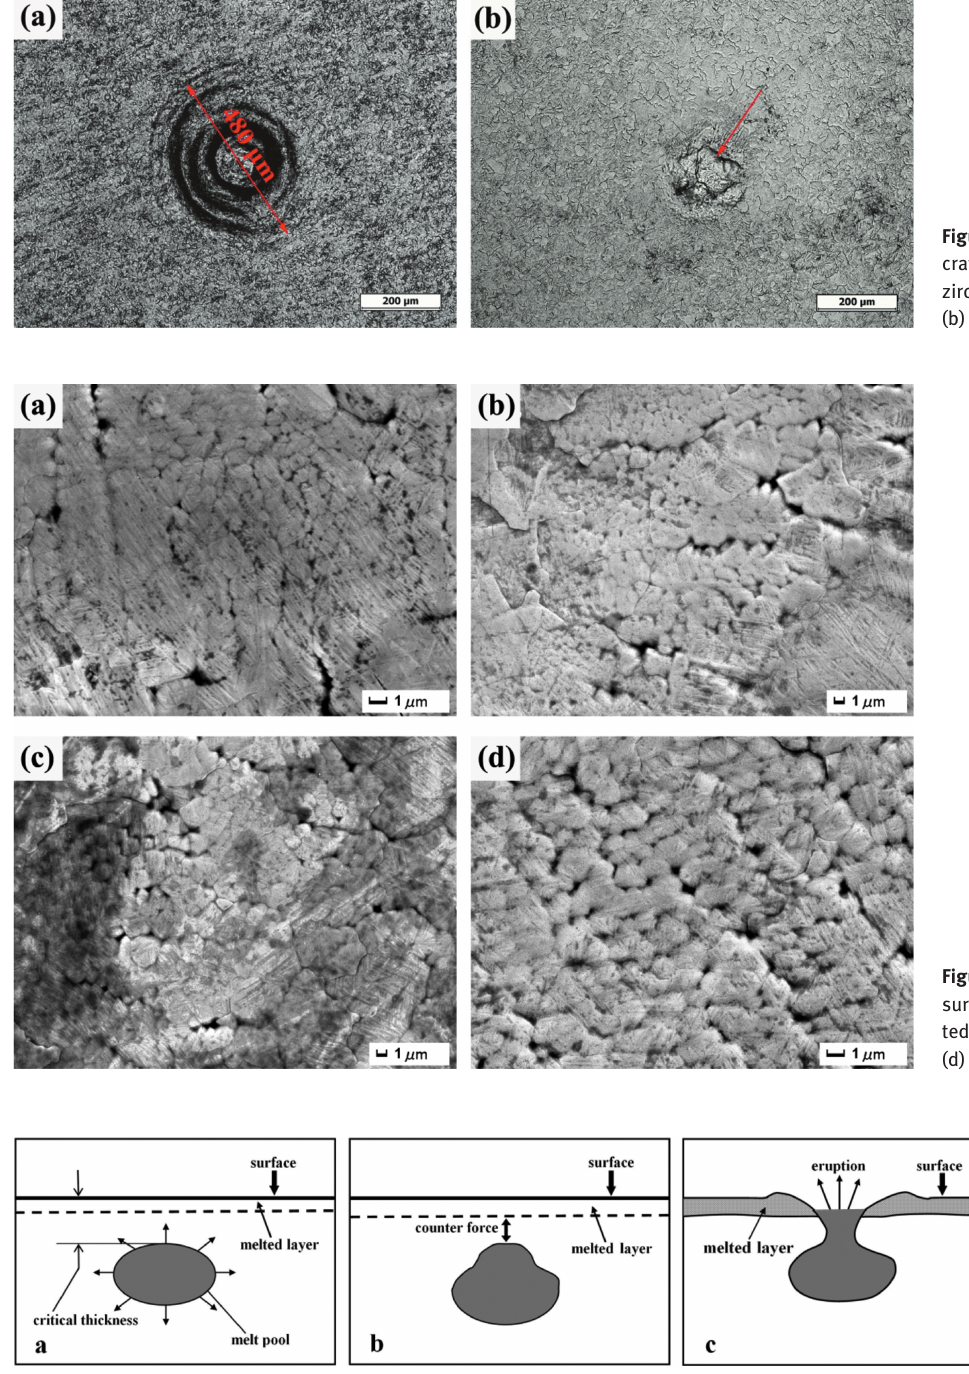
Figure 5: Schematic illustration of craters that succeeded to be erupted of 3Cr13 stainless